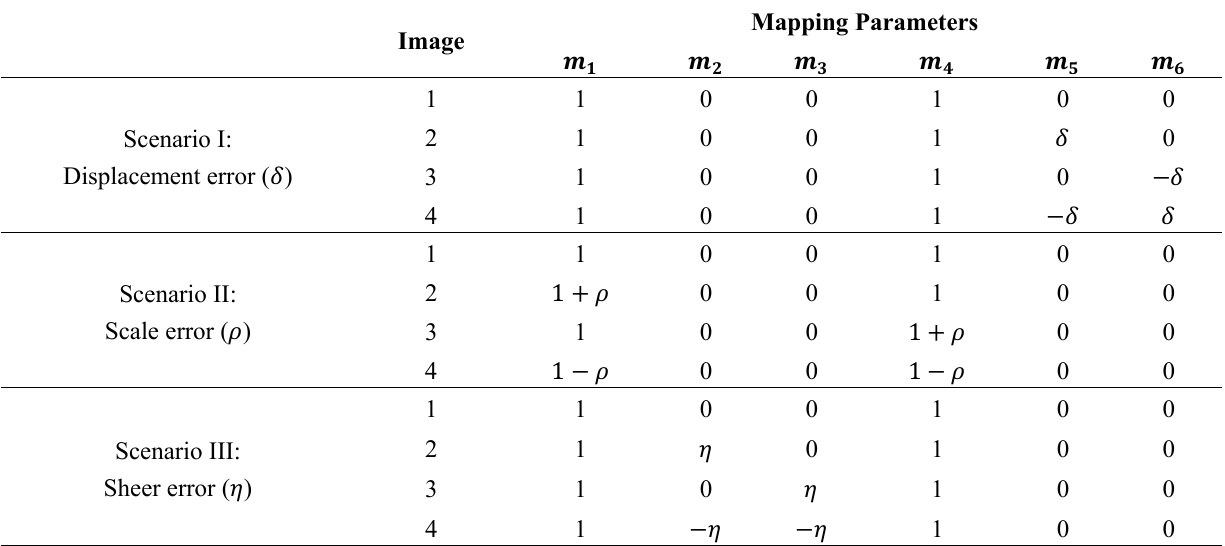
Table 1. Three scenarios for mapping parameter errors in Example 1. Mapping Image